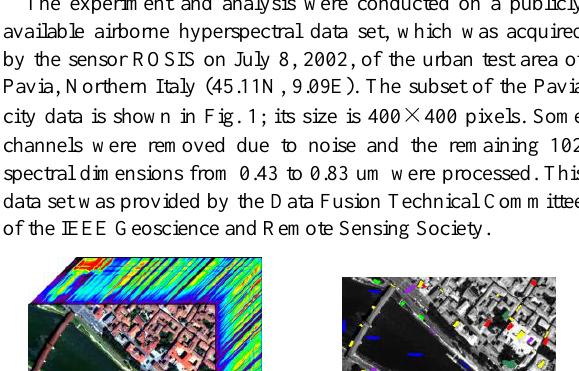
First row: spectral feature images.